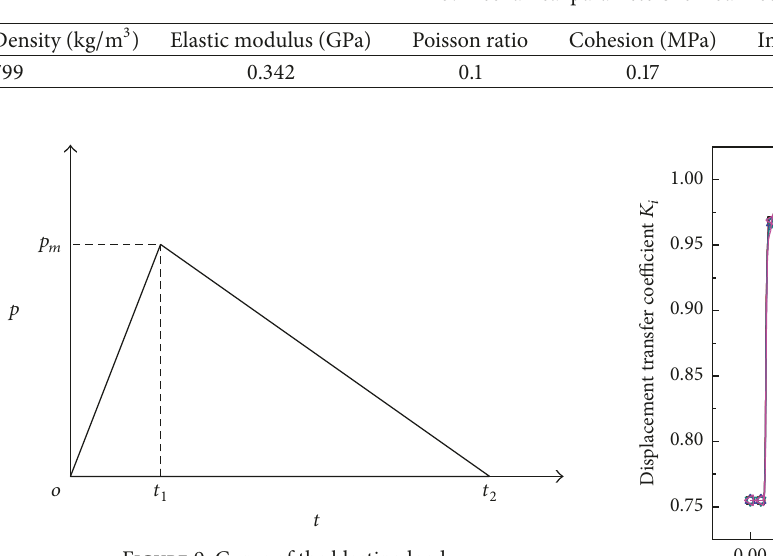
Figure 9: Curve of the blasting load.